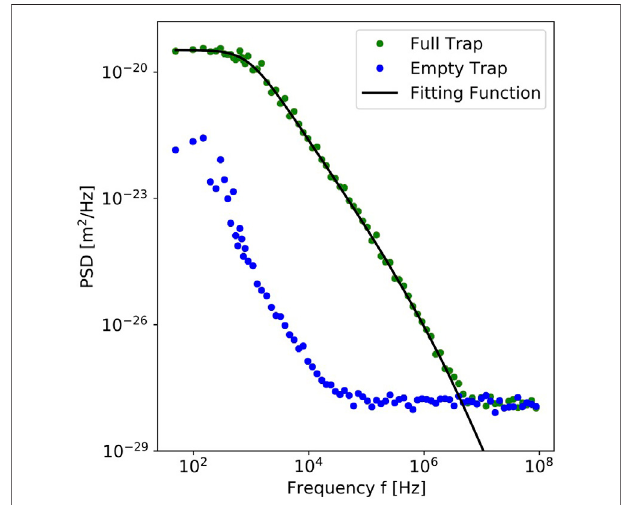
FIGURE 2 | Power spectral density (PSD, green dots) of a 0 . 915 μ m diameter PMMA particle at an ambient temperature of T 0 (cid:2) 23 ° C. The found trap stiffness corresponds to k (cid:2) 44 . 6pN / μ m at a trapping power of P (cid:2) 14 . 5 mW. The black line displays the theoretical fi tting function (see Appendix ). The blue dots display the power spectral density of the empty trap.